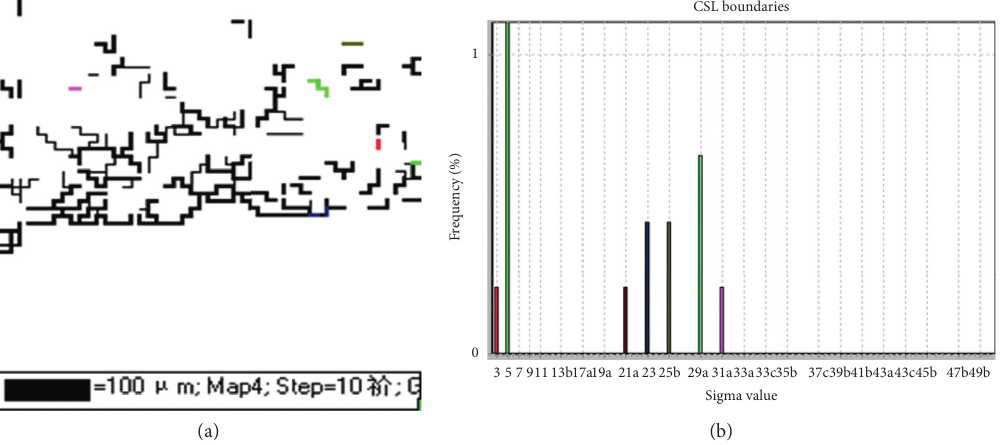
Figure 12: The CSL grain boundary of the abnormal grain and its surroundings.